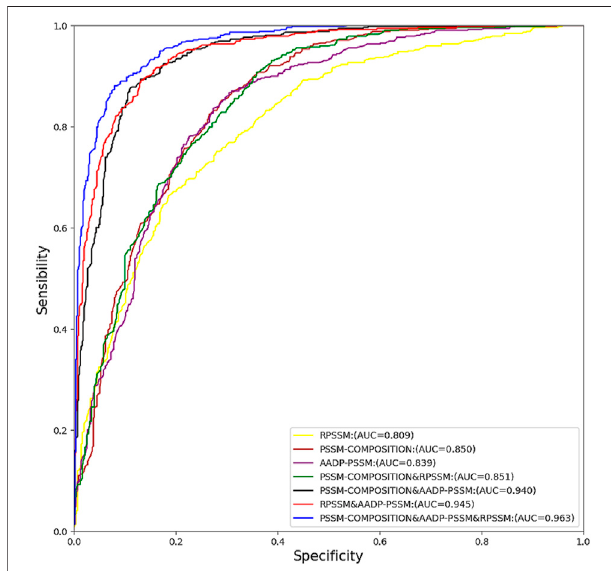
FIGURE 2 | ROC curves with different combinations of features on PDB1075.